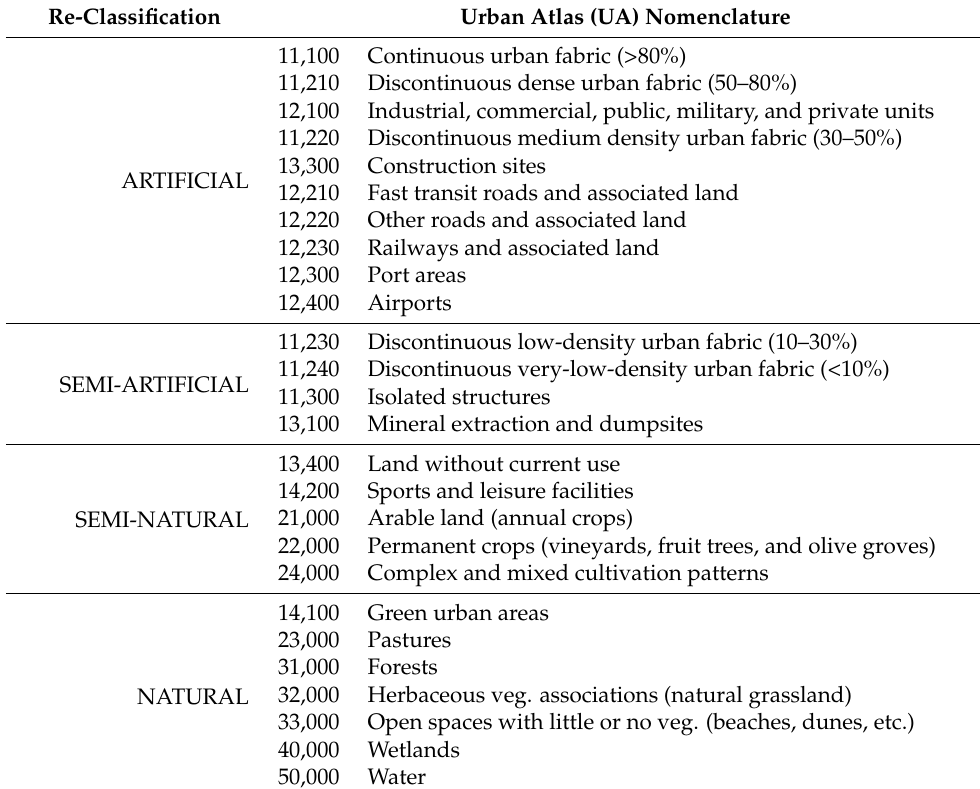
Table 1. The re-classification of the UA classes into four categories; artificial, semi-artificial, semi- natural, and